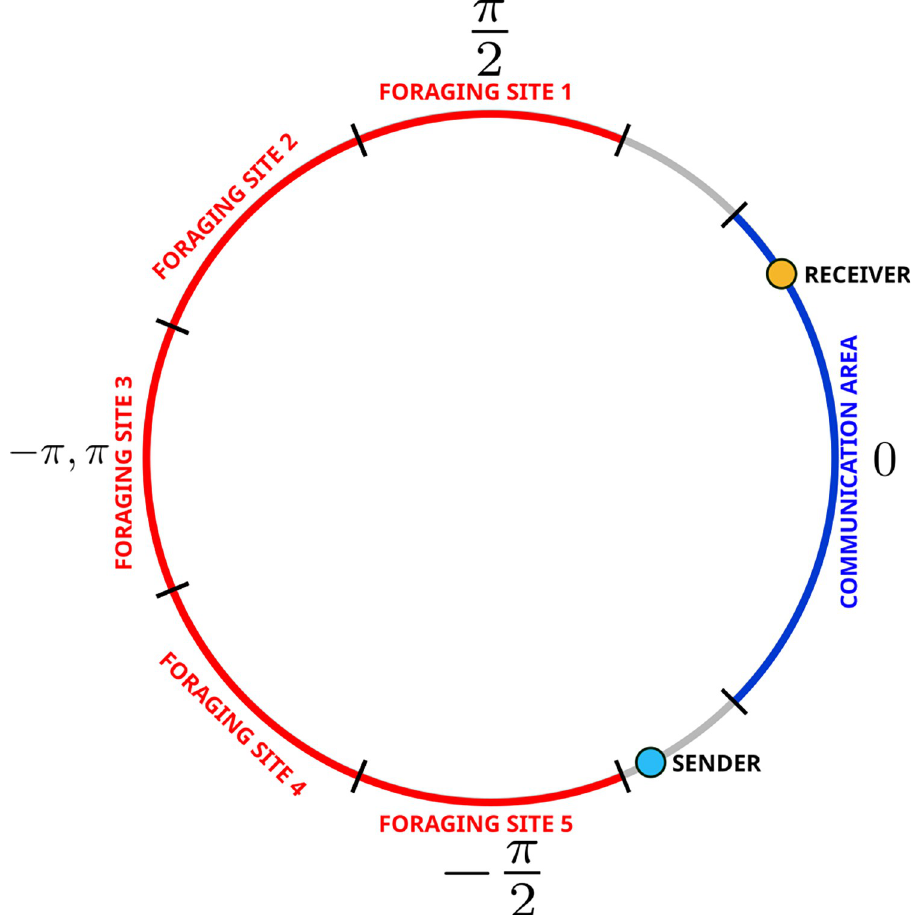
Fig 1. Illustration of experimental setting. At each trial, food was randomly located on one of the five foraging sites (marked in red) equally spaced on a one-dimensional circle. Both the sender and the receiver always started a trial at position 0 on the circle located within the communication area, which acted as a “nest” (marked in blue). Agents moved on the border of the circular environment in a direction or the other (clockwise or counterclockwise). See Materials and Methods for a complete description of the experimental